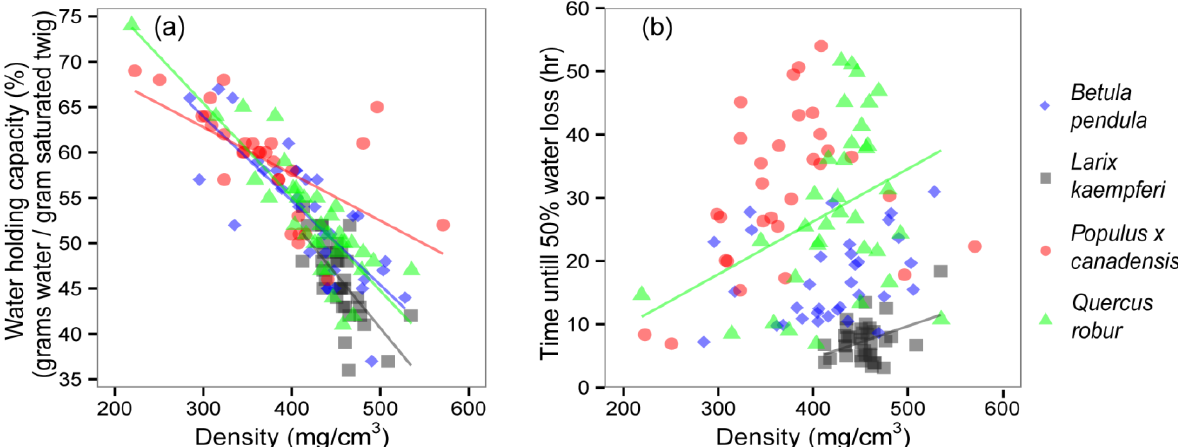
Table 1. Summary of statistics of linear models for water holding capacity (WHC),